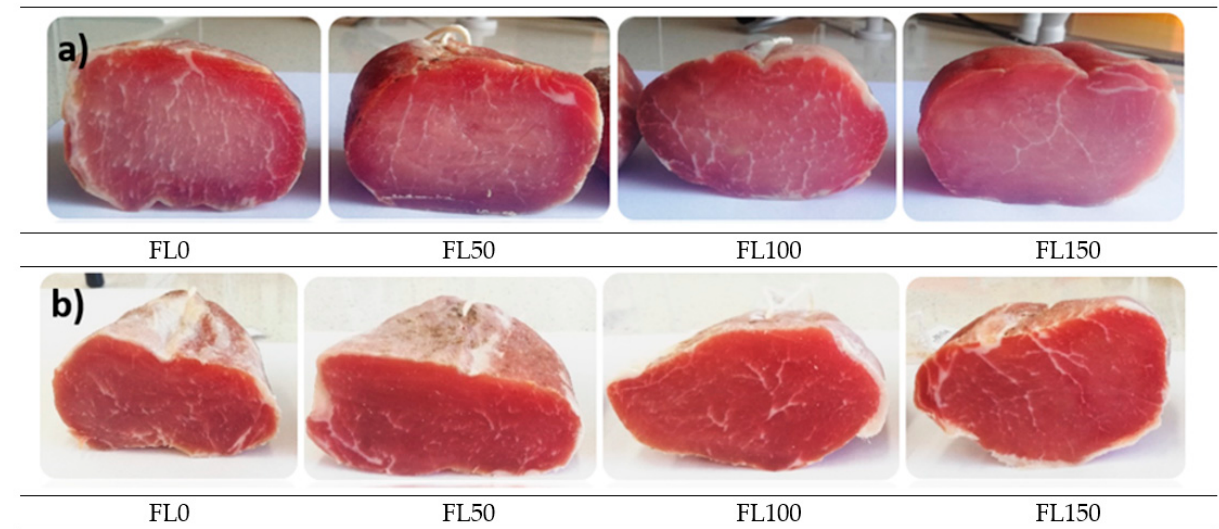
Figure 1. Cross-sectional appearance of fermented loins ( a ) after the production process, ( b ) after six months of storage. FL0 (sample without sodium nitrate addition); FL50 (sample with reduced amount of sodium nitrate to 50 mg kg − 1 ); FL100 (sample with reduced amount of sodium nitrate to 100 mg kg − 1 ); FL150 (sample with traditional amount of sodium nitrate 150 mg kg − 1